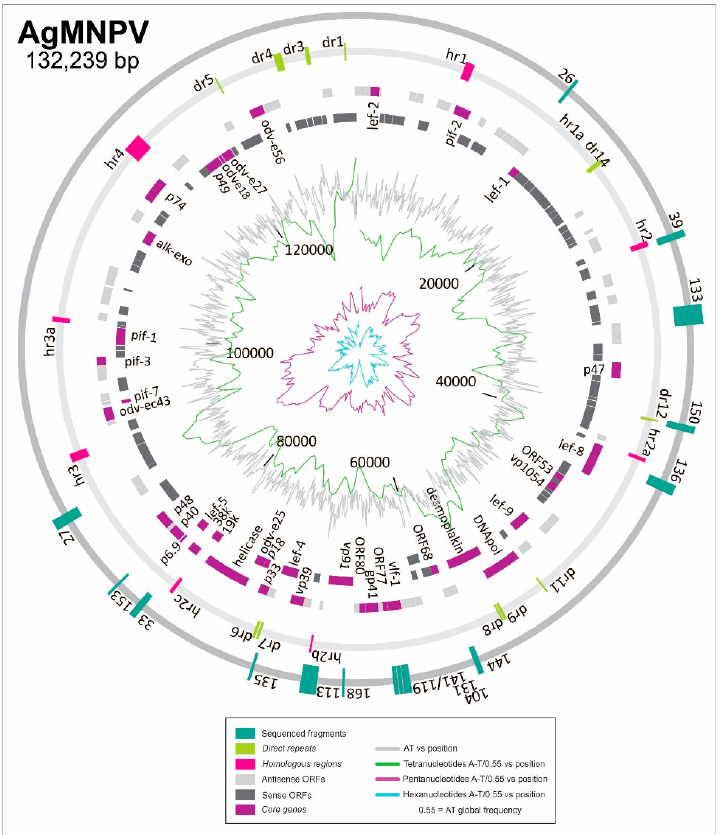
Figure 2. AgMNPV ORI sequences. The illustration shows the physical maps of AgMNPV loci containing the segments recovered as ORI by the transient replication assay. They are indicated as green boxes and named using the corresponding clone number derived from the AgMNPV library. The annotated ORFs are represented with different grey shaded boxes (dark grey and light grey). Core genes are indicated in violet boxes and named according to the traditional denomination. The homologous regions ( hrs ) and direct repetitions ( drs ) are indicated using pink and light green boxes, respectively. Inside the circle that represents the genome, the AT content (gray line) and the profiles of appearance of 4mer (green line), 5mer (violet line), and 6mer (blue line) runs containing only A or T are shown.